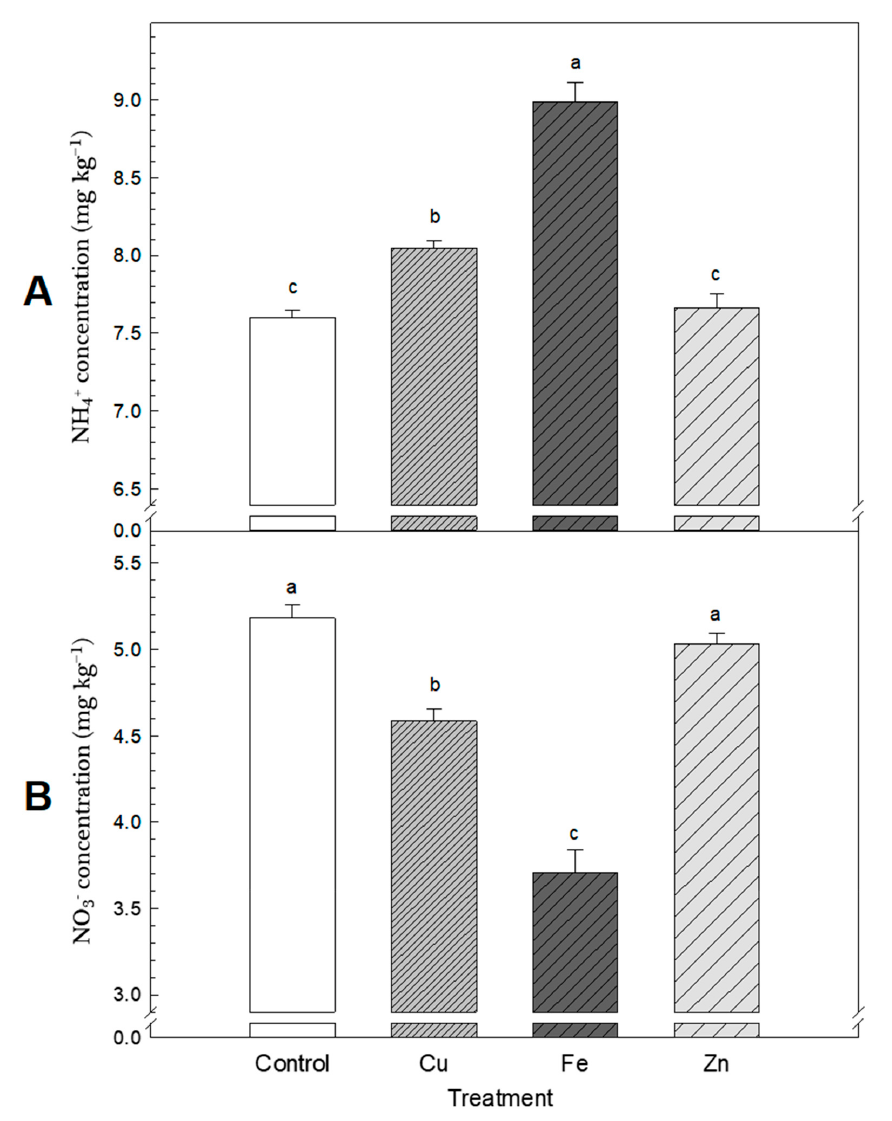
Figure 2. Mean values of ammonium ( A ) and nitrate ( B ) in upland soils amended with different metals at harvest across both years. Different lowercase letters denote significant difference at p <0.05 level.